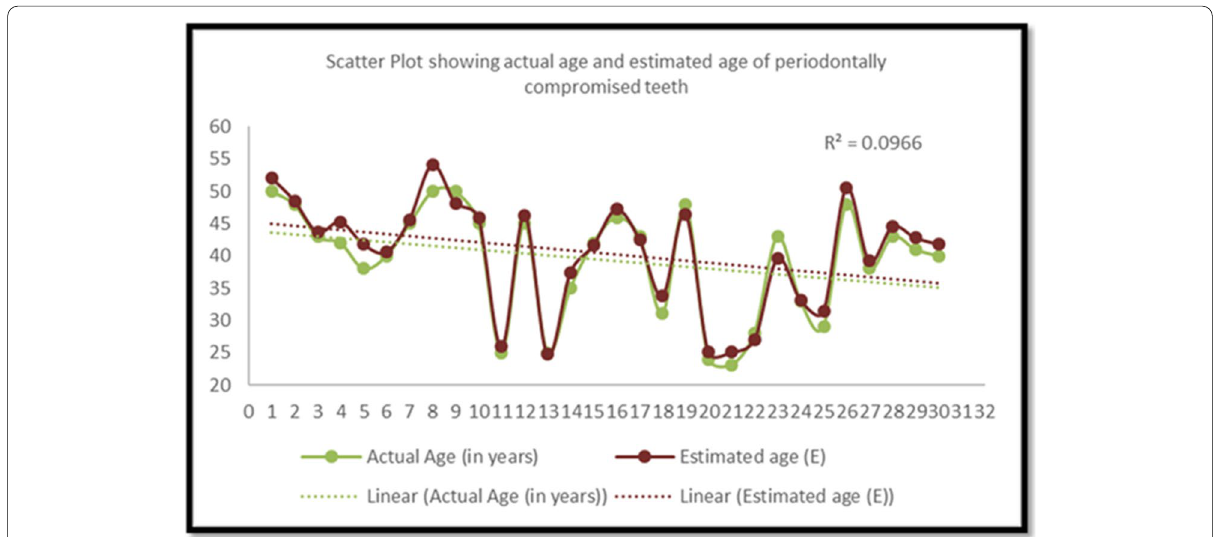
Fig. 7 Scatter plot showing actual age and estimated age of periodontally diseased